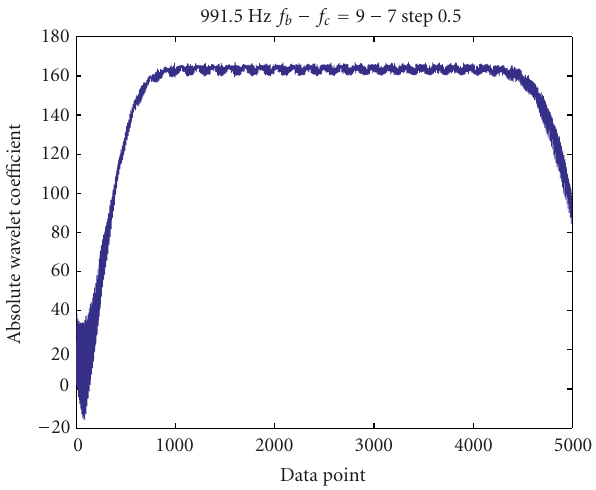
Figure 6: Absolute wavelet coe ffi cients plot generated by CWT (us- ing complex Morlet wavelet, f b = 9, f c = 7) for harmonic frequency at 991.5 Hz.